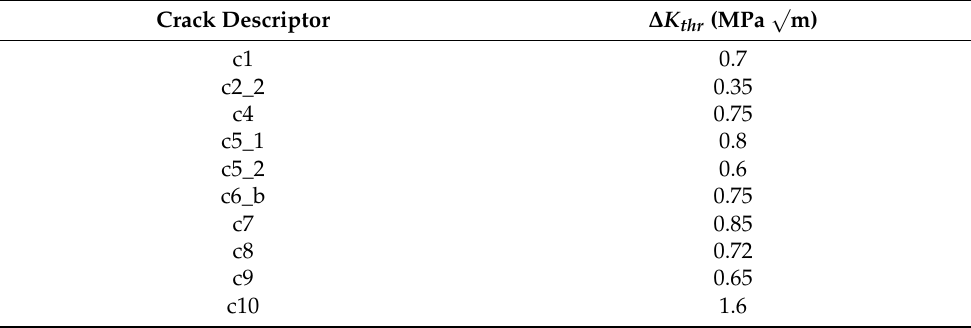
Table 5. Values of the term ∆ K thr given in [16]. Crack